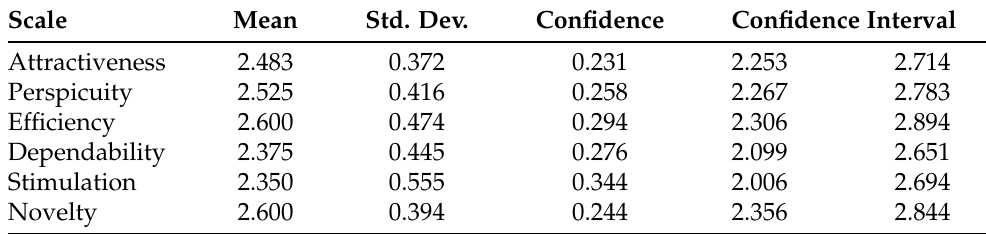
Table 1. Students results ( n = 10). Confidence interval ( p = 0.05) per